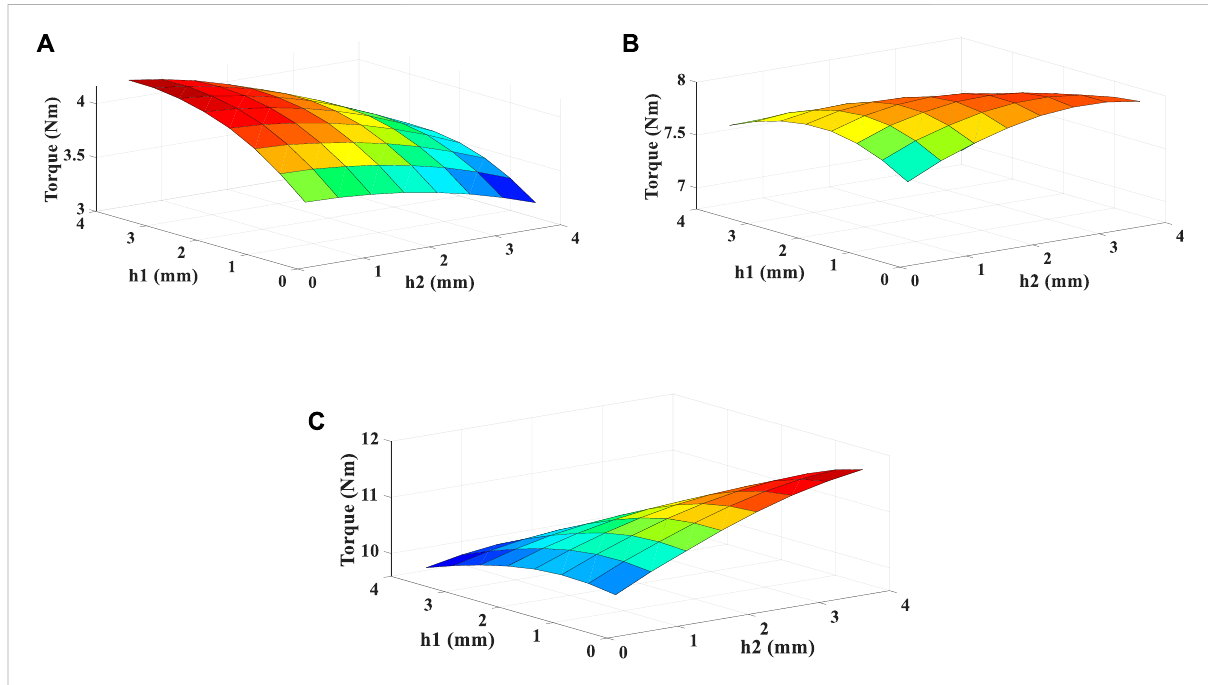
FIGURE 8 Average torque with variable usage of dual-ferrite PMs under different current densities (A) 5 A/mm2. (B) 10 A/mm2. (C) 15